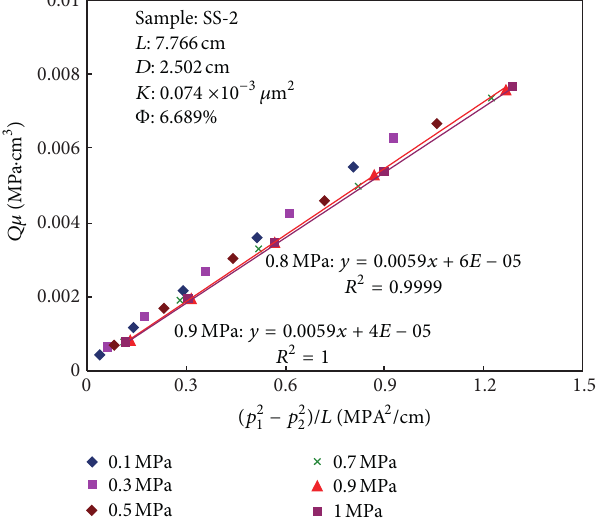
Figure 4: Relationships between (𝑝 2 1 − 𝑝 2 2 )/𝐿 and 𝑄𝜇 at various backpressures for sample